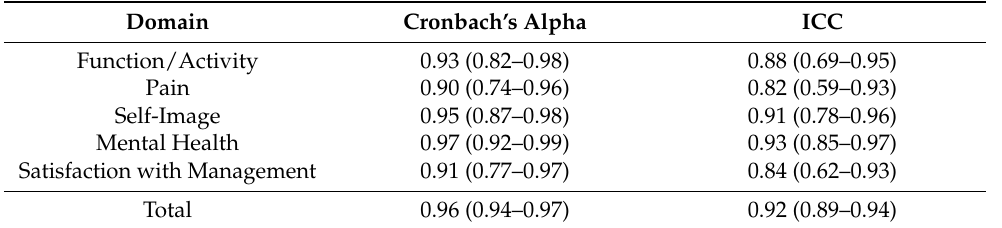
Table 3. Reliability and internal consistency of the German LD-SRS score and its subscales. Cronbach’s alpha and the intraclass correlation coefficient (ICC) were normally distributed; thus, both values are reported, including the 95% confidence